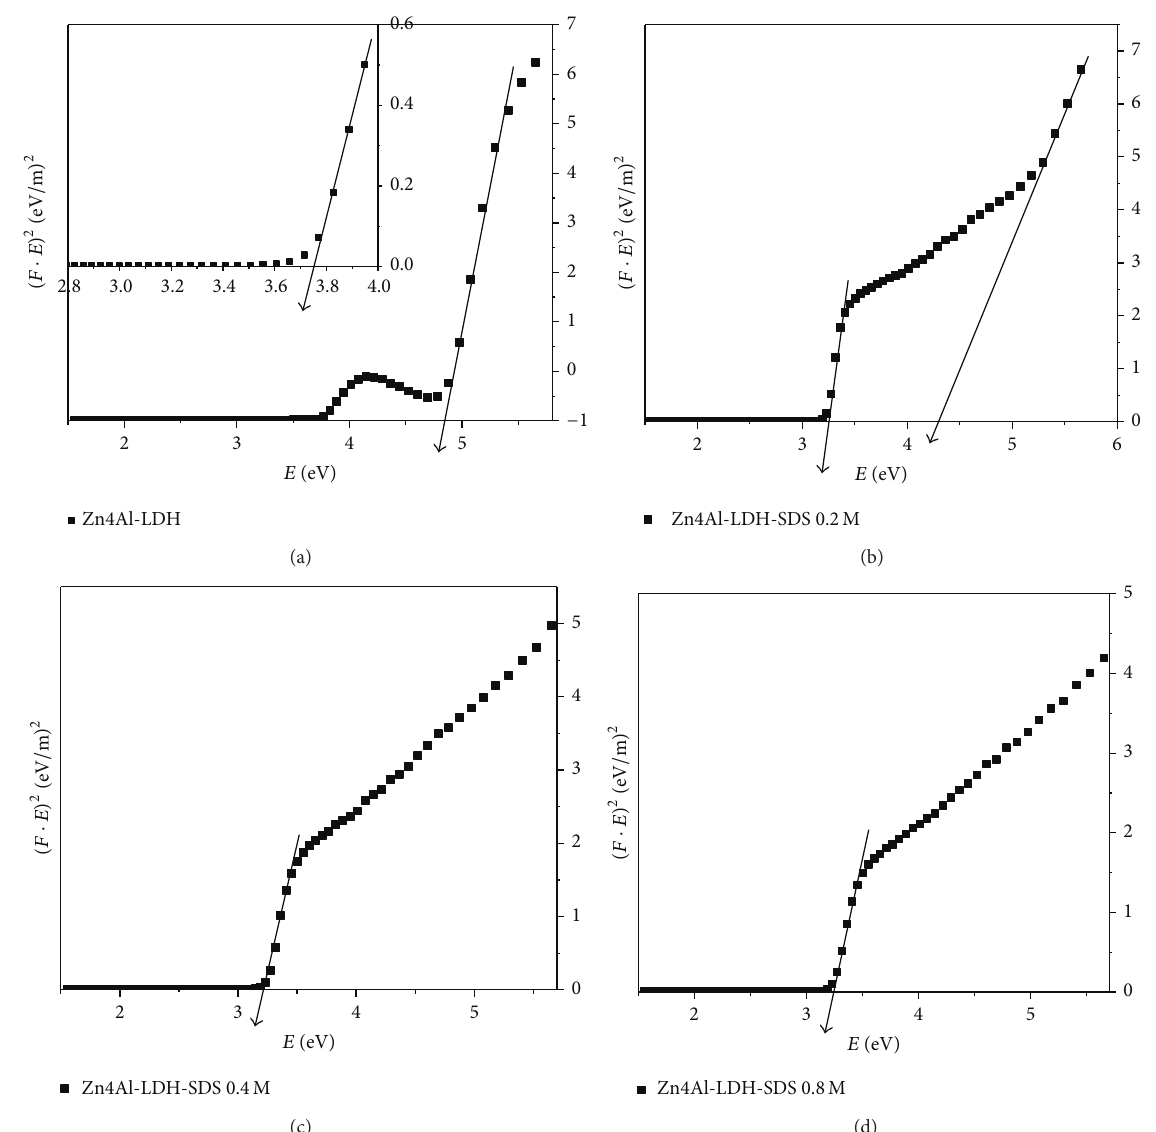
Figure 5: Kubelka-Munk transformed reflectance spectra of Zn4Al–NO 3 –LDH and LDH-SDS in different